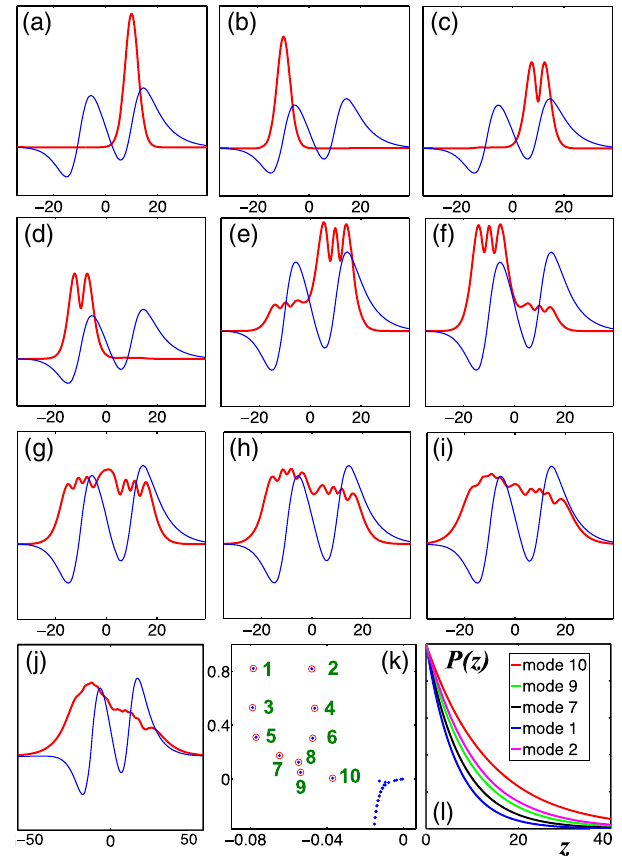
FIG. 8. (a-j) Spatial field amplitudes (normalized to 1) of the 10 bounded modes (red curves) of the non-normal potential of Fig. 1(b), for g ¼ 1 as a function of the transverse coordinate x . The blue curves represent the imaginary part of the potential. (k) The eigenvalue spectrum in the complex plane. The red dots denote the ten guided modes of the structure. The eigenvalues are sorted based on the magnitude of their imaginary part. (l) Power decay (normalized to 1) of the individually excited eigenmodes versus the propagation distance z